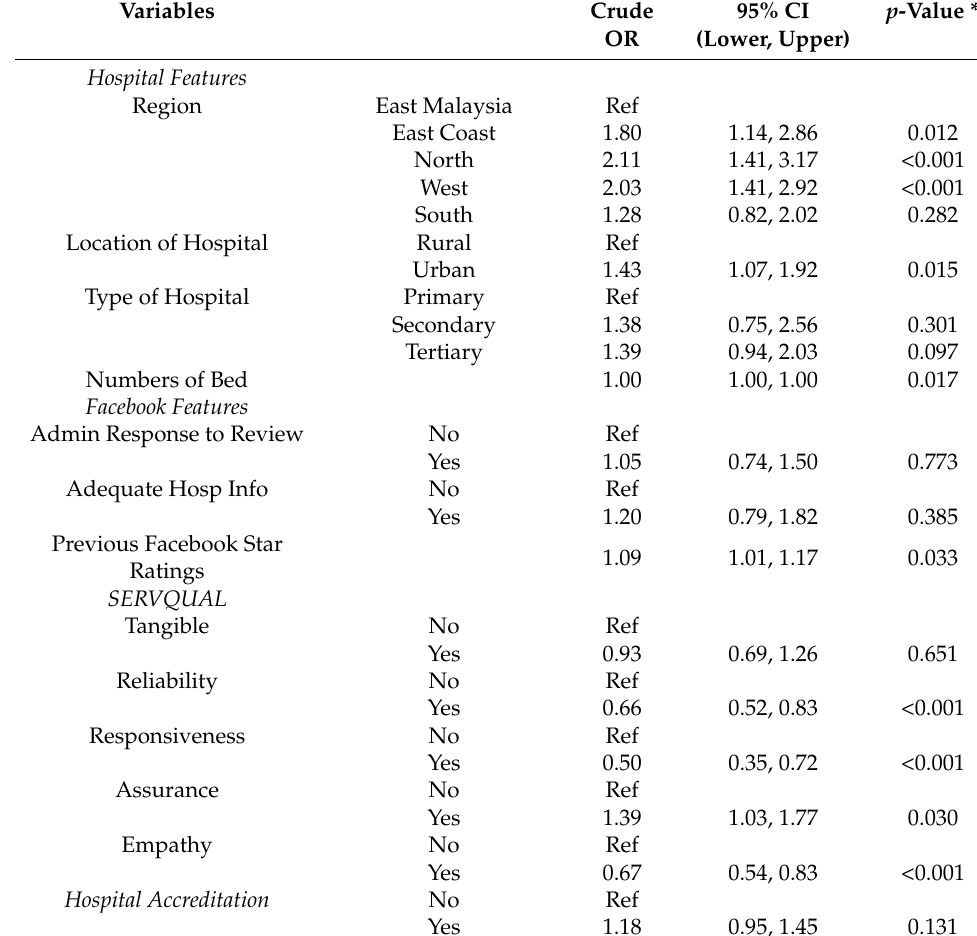
Table 6. Determinants of positive sentiment using univariate analysis ( n = 1825).